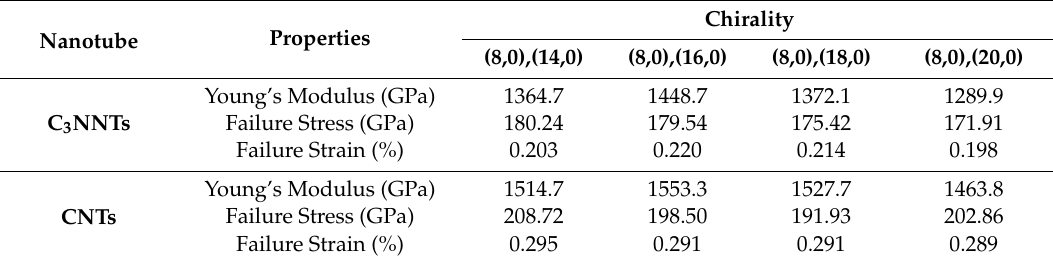
Table 5. Same as Table 4, but for zigzag DWC 3 NNTs and DWCNTs.